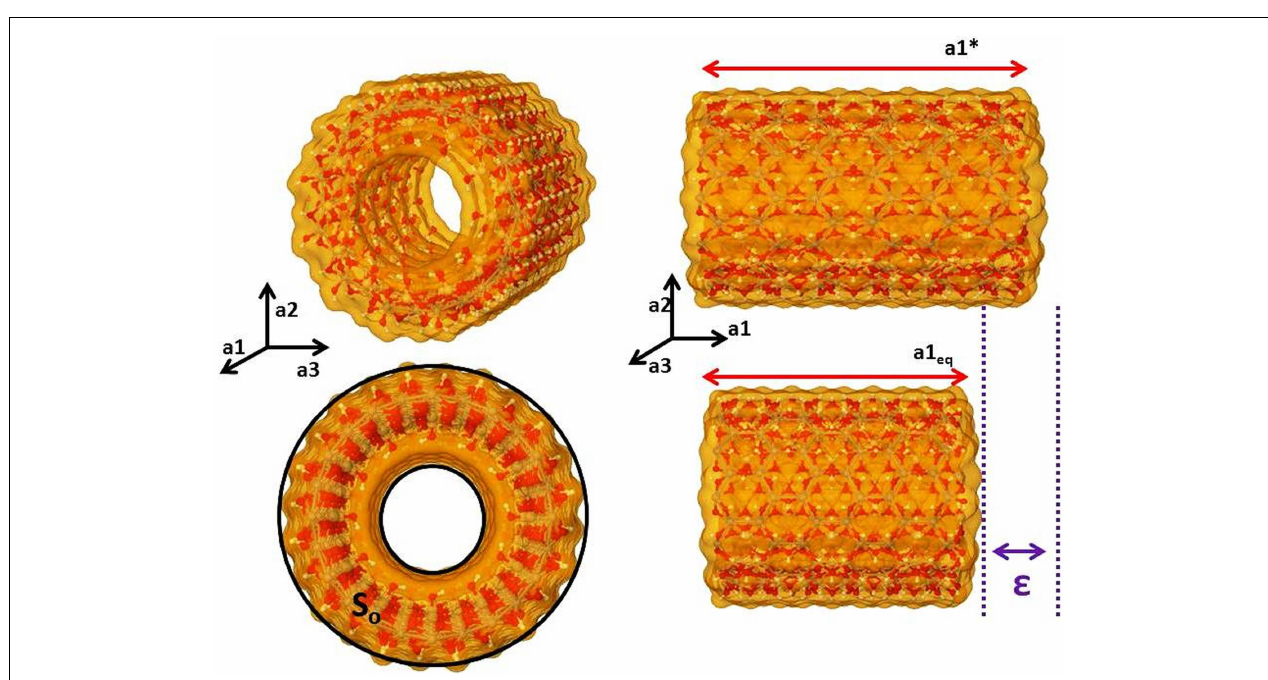
FIGURE 2 |The unit cell of imogolite (12,0) showing the transversal area ( S o ), lattice vector ( a 1eq ), periodic axis ( a 1 , a 2 , a 3 ), stressed periodic vector ( a 1* ), and the deformation parameter ( ε ) .